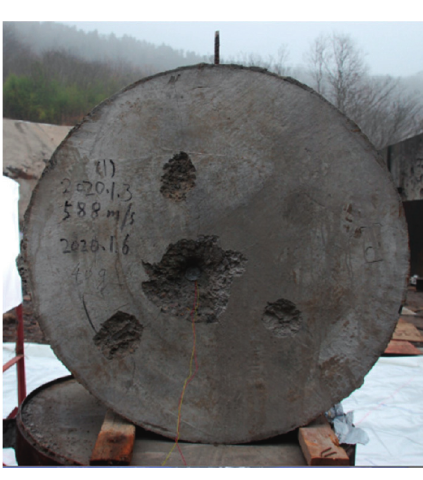
Figure 7: Cylindrical charge layout.